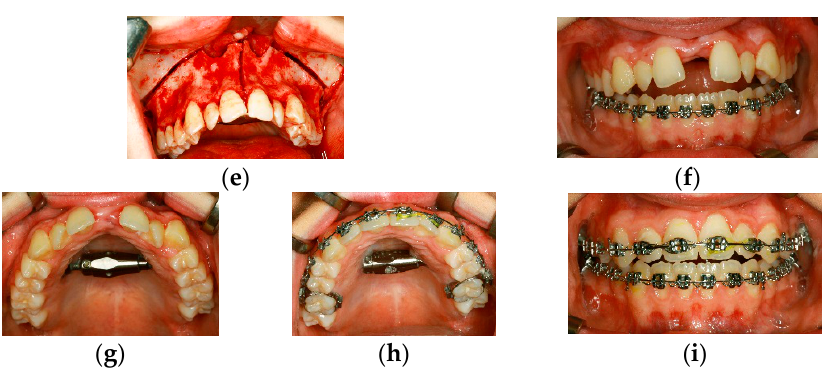
Figure 2. ( a , b ) Preoperative clinical situation in a 15 ‐ year old female patient affected by transverse maxillary deficiency and dental crowding in the anterior maxillary arch; ( c – e ) Intraoperative situation during insertion of a transpalatal distraction device, ( c ) anterior maxillary osteotomies were performed by piezosurgery, ( d ) intraoperative activation of the device to the extent needed, for that purpose bone strips have to be removed bilaterally ( e ); ( f – i ) Clinical situation during active distraction ( f , g ) and after orthodontic closure of the diastema ( h , i )—residual open bite is likely to be managed by orthodontic means alone.